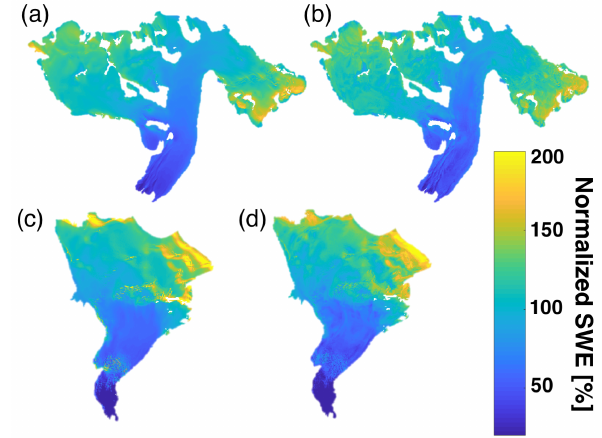
Figure 8. The 5-year mean of normalized distributed SWE for Gulkana (a, b) and Wolverine (c, d) for multivariable regression (a, c) and regression tree (b, d)